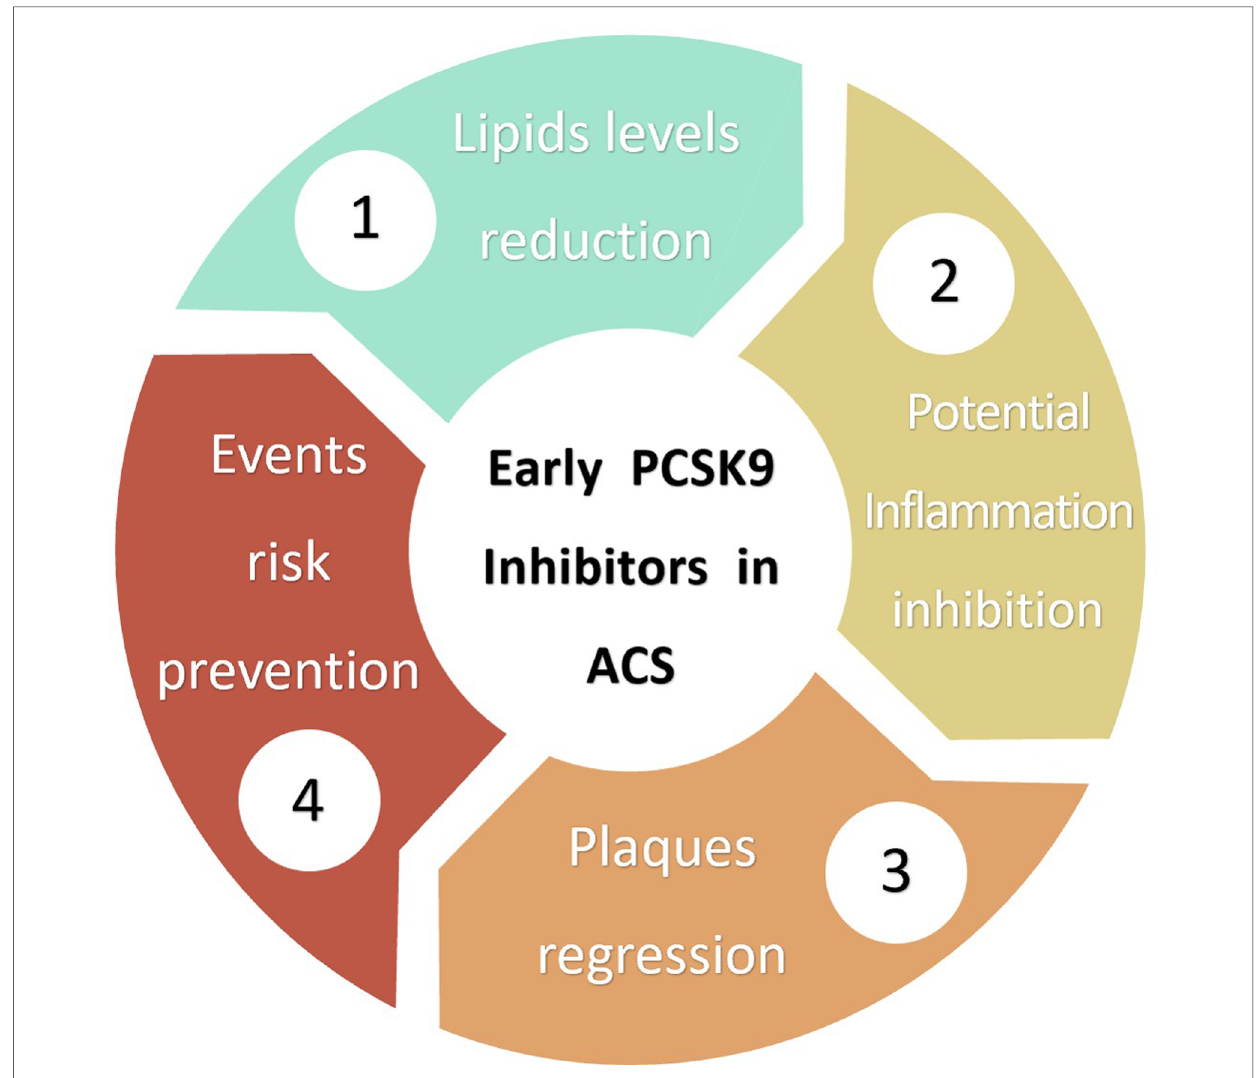
FIGURE 1 Bene fi ts and potential bene fi ts of early PCSK9 inhibitors in